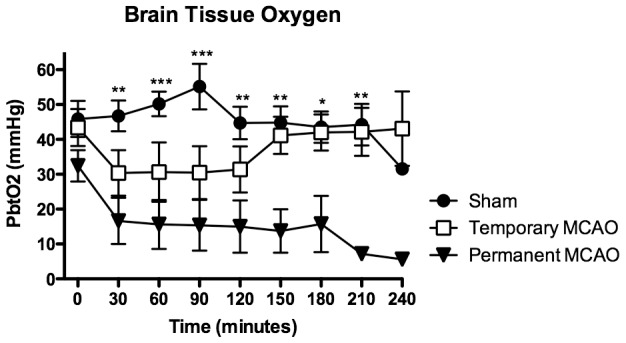
PbtO2 after surgical MCAO, first 4 hours.After permanent MCAO, PbtO2 falls significantly compared to sham. PbtO2 begins to rise again upon release of the temporary aneurysm clip in the transient occlusion group, however remains low in the permanent occlusion group. Sham animals demonstrate no significant change for the duration of the monitoring period. *, p<0.05; **, p<0.01; ***, p<0.001 (permanent MCAO compared to sham).